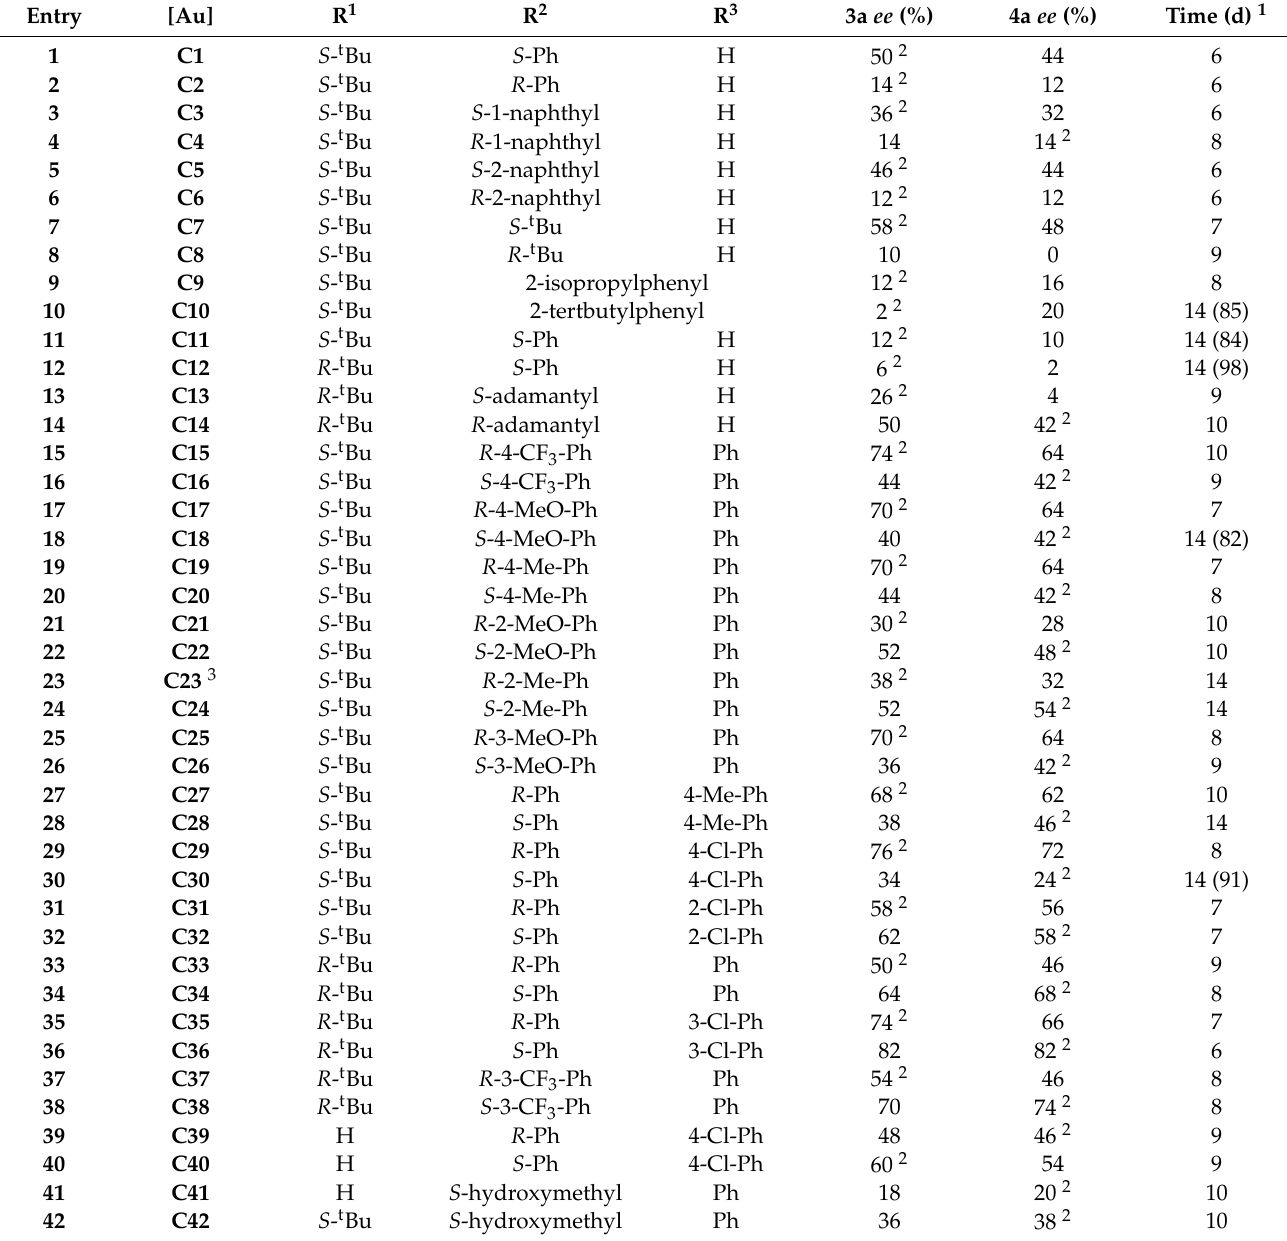
Table 1. Catalyst screening ( C1–42 ) in the asymmetric